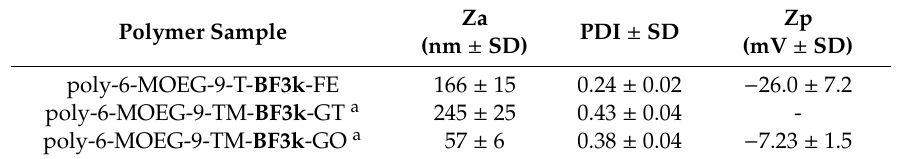
Table 2. Dynamic light scattering (DLS) results obtained with poly-6-MOEG-9-T- BF3k -FE in ultrapure water at 25 °C (reported data are those recorded after 2 days) compared with those obtained with parent PPBFB derivative poly-6-MOEG-9-TM- BF3k samples.